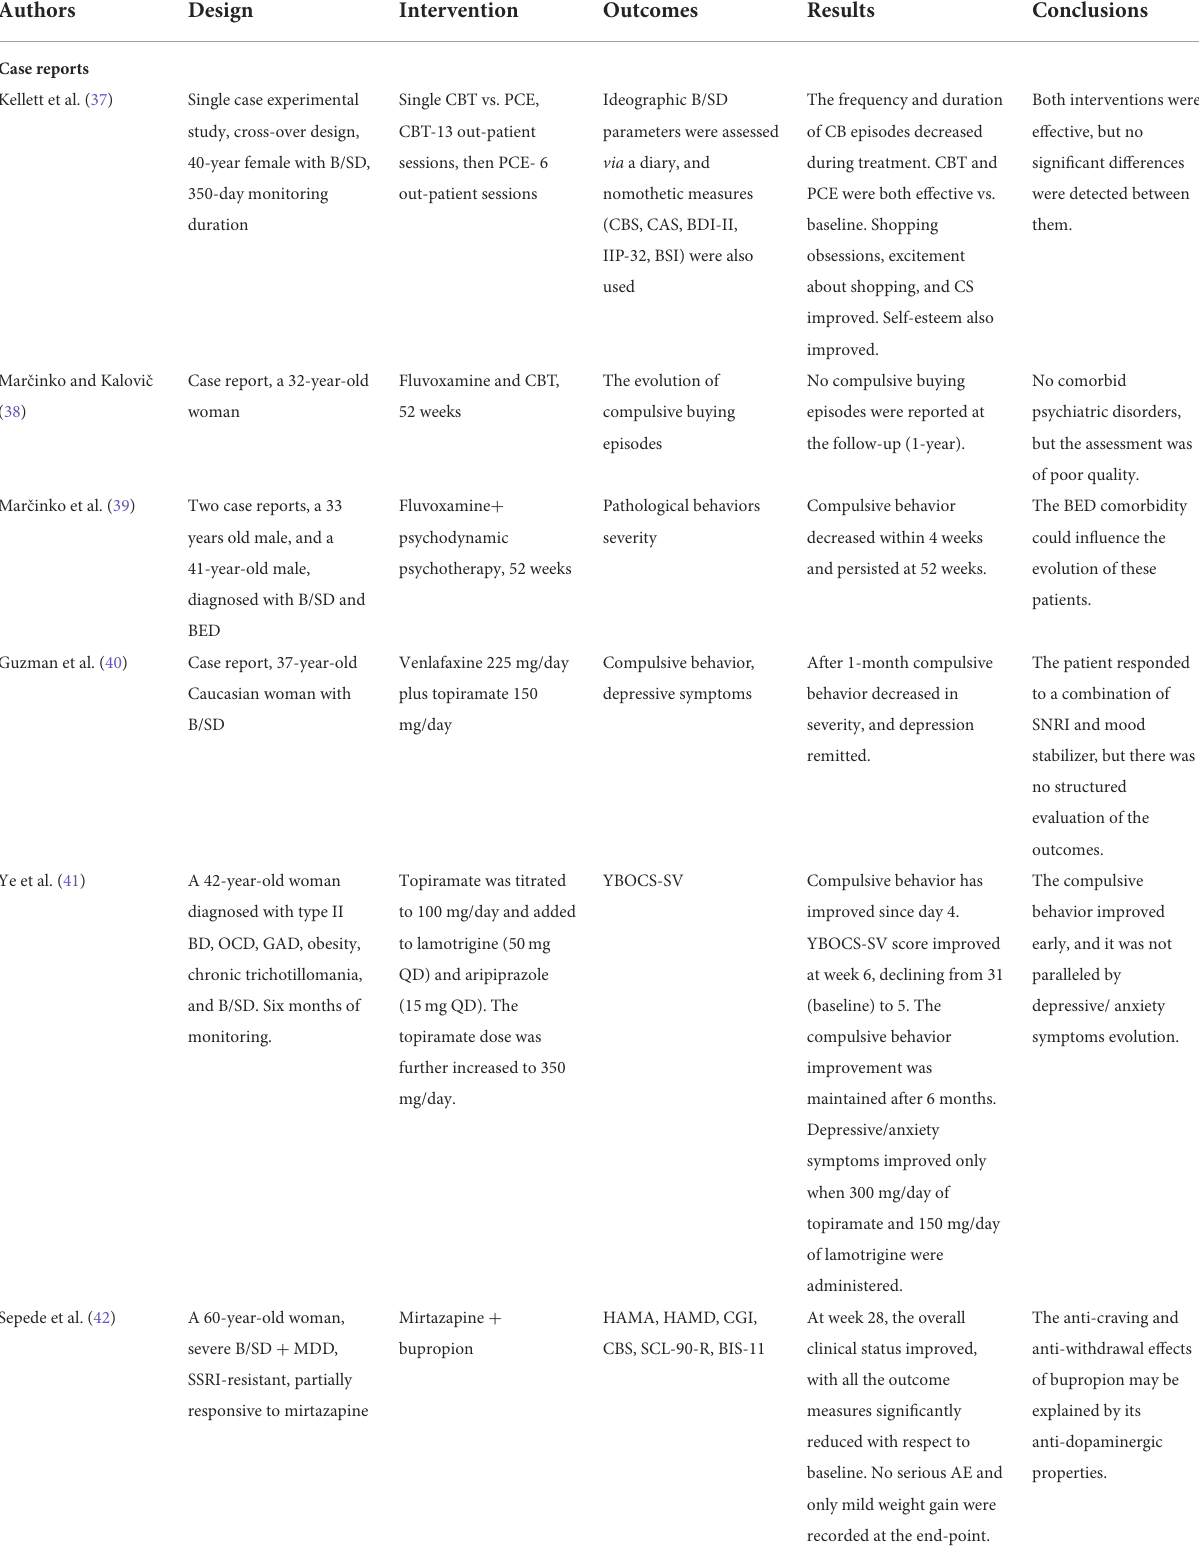
TABLE 3 The main data reviewed for the evaluation of the efficacy and tolerability of therapeutic interventions in patients with